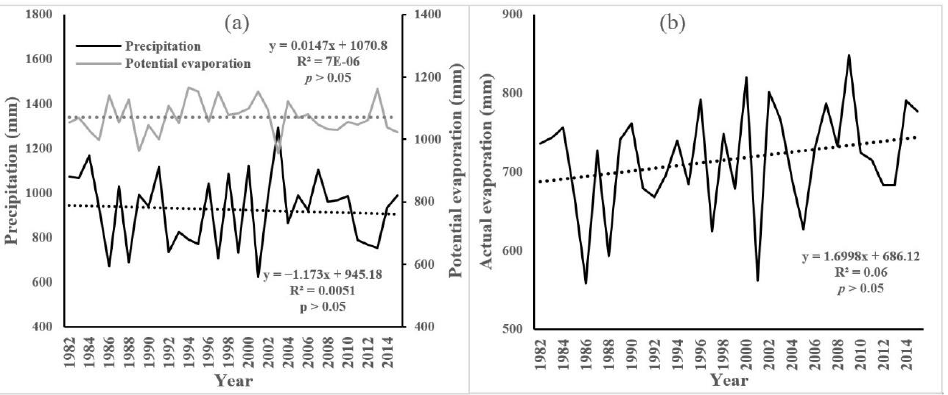
Figure 3. Change tendencies of the precipitation, potential evaporation, and actual evaporation in the MUHR.